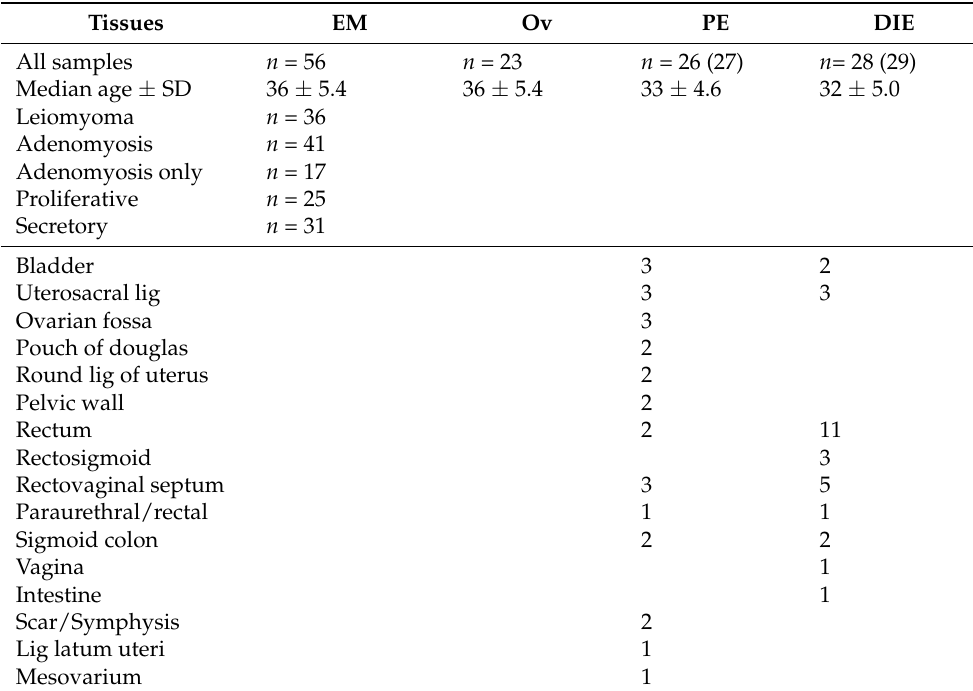
Table 1. Overview of the tissue samples used for